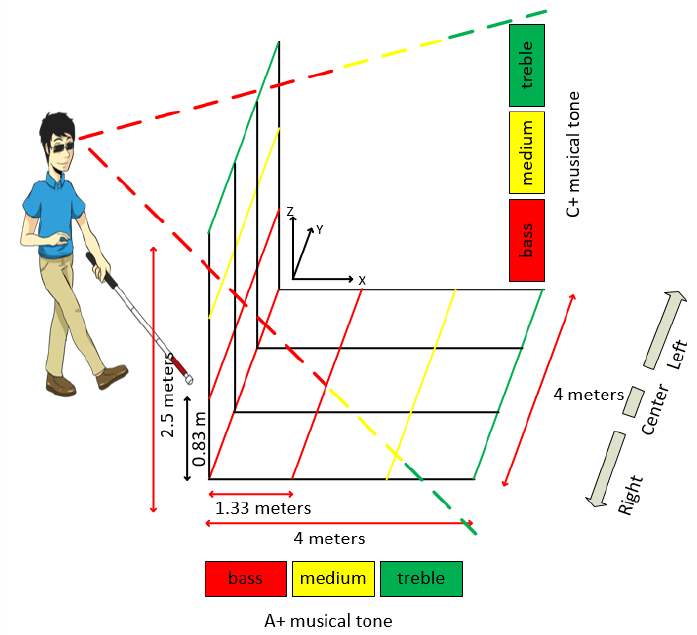
Figure 9. Obstacle detection scheme using stereo vision and audible alerts.